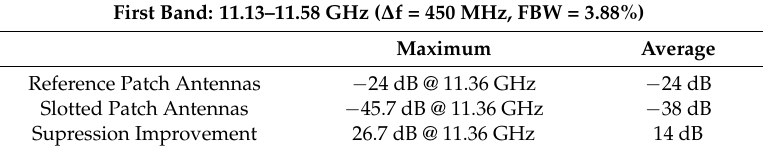
Figure 2. Reflection and transmision coefficients of the reference and proposed antenna array. ( a ) Coverage over X-band; ( b ) Coverage over the first Ku-band; ( c ) Coverage over the second Ku-band; ( d ) Coverage over the third Ku-band and K-band. Table 1. Isolation in the X-band.